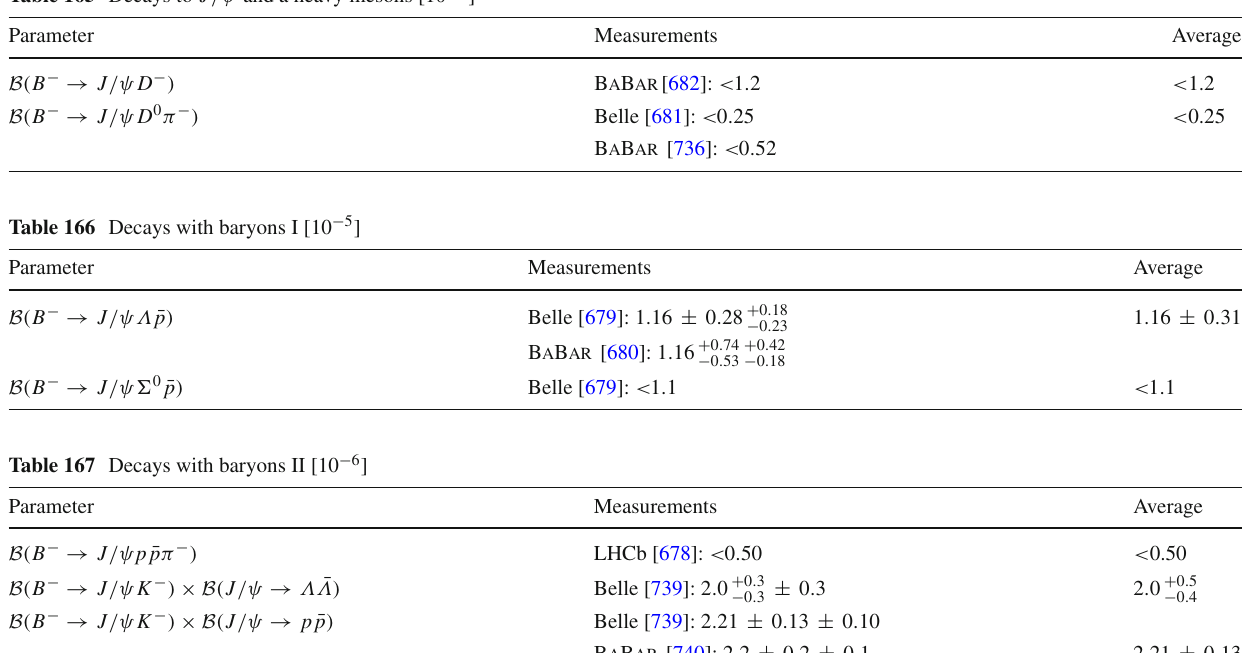
Table 165 Decays to J /ψ and a heavy mesons [ 10 − 4 ]